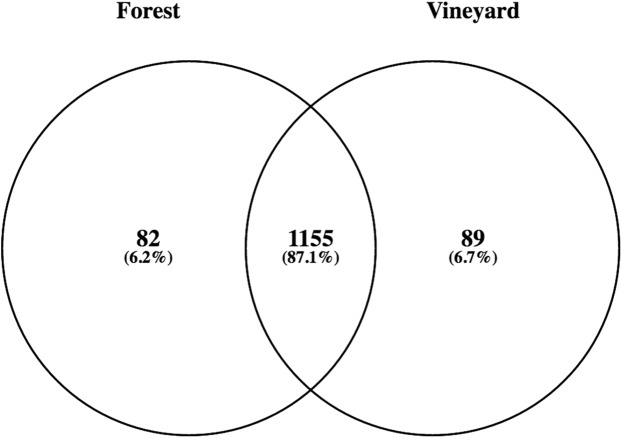
Numbers and percentage of bacterial species found in forest and vineyard soils.The number in the overlapping zone indicates how many species were shared between forest and vineyard soils, and the numbers in the non-overlapping zone indicate how many species were exclusively found in each habitat.